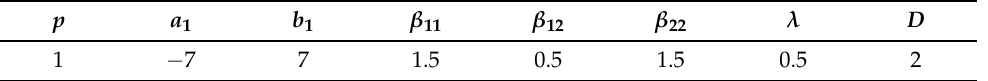
Table 1. Table of the parameter values employed in the numerical simulations of this manuscript. p a 1 b 1 β 11 β 12 β 22 λ D 1 − 7 7 1.5 0.5 1.5 0.5